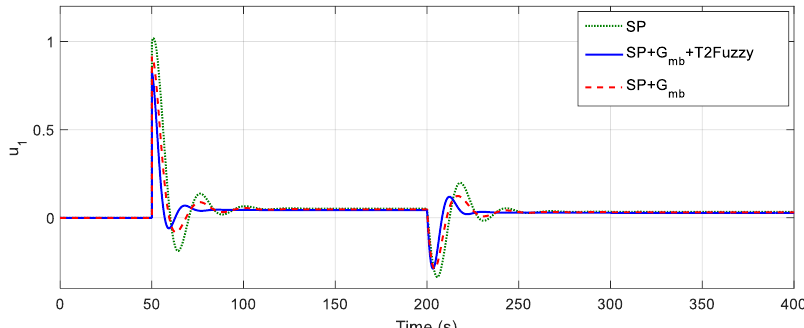
Figure 8. Performance of three control methods for 𝑦 2 for example 1.